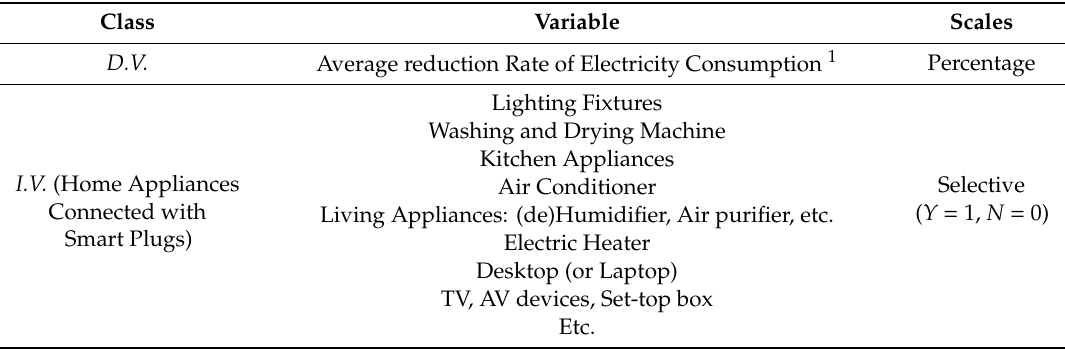
Table 2. Dependent ( D.V. ) and Independent ( I.V. ) Variables of Research Model